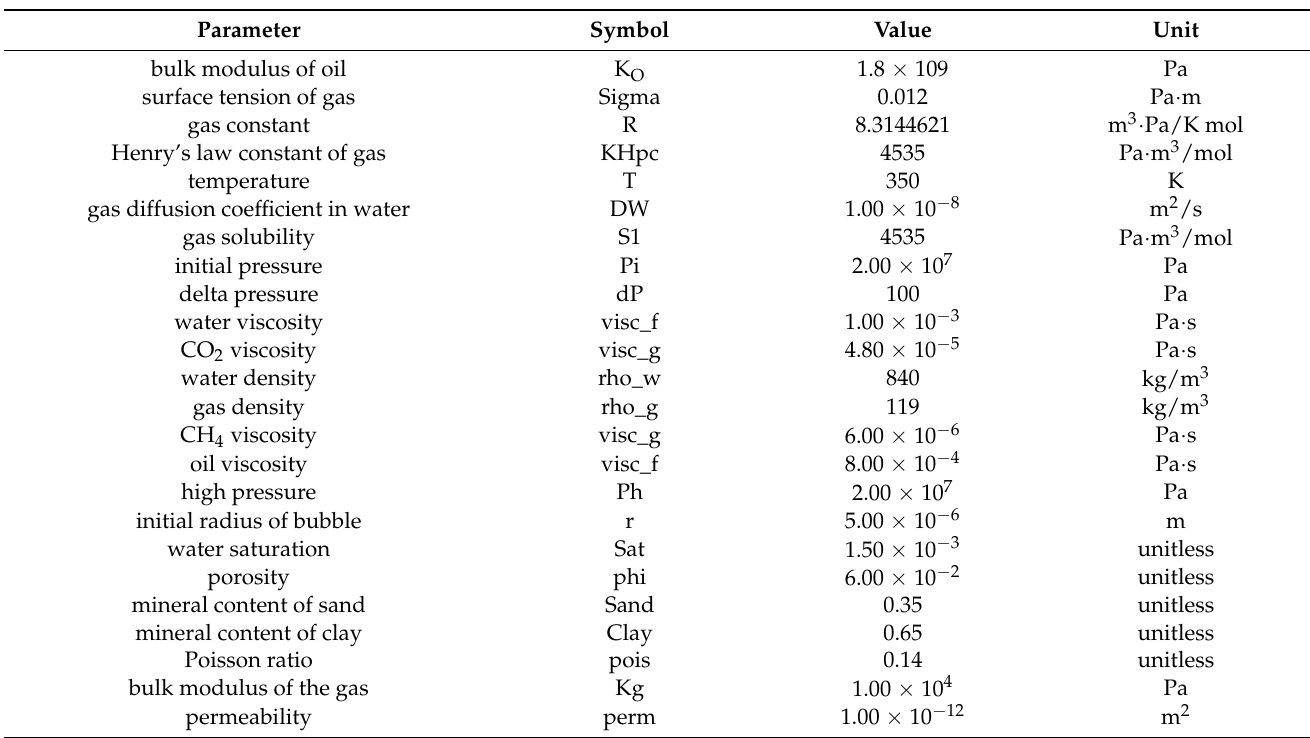
Table 1. Parameters used in three rock physics models: the pore fluid dissolution model, the SLS model and the Pride model.